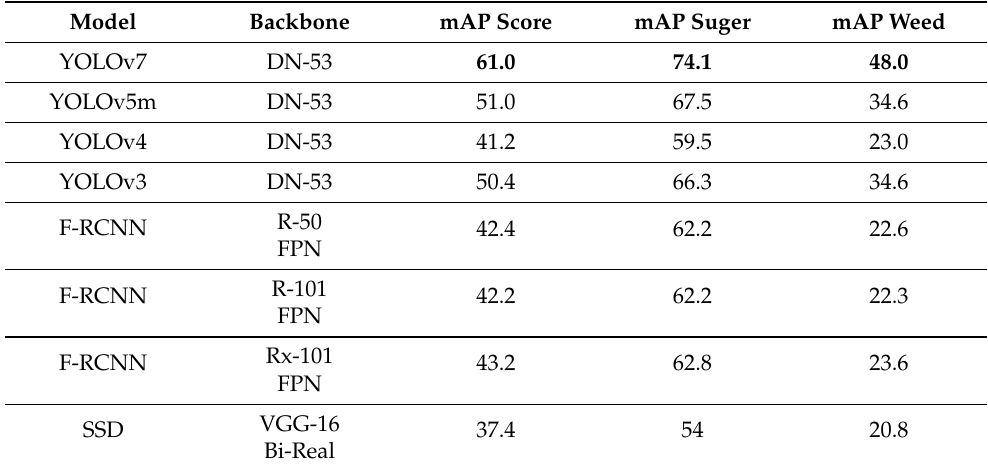
Table 4. Performance of the proposed YOLOv7 model, trained for 300 epochs on the LB dataset and compared to other models. The best results are highlighted in